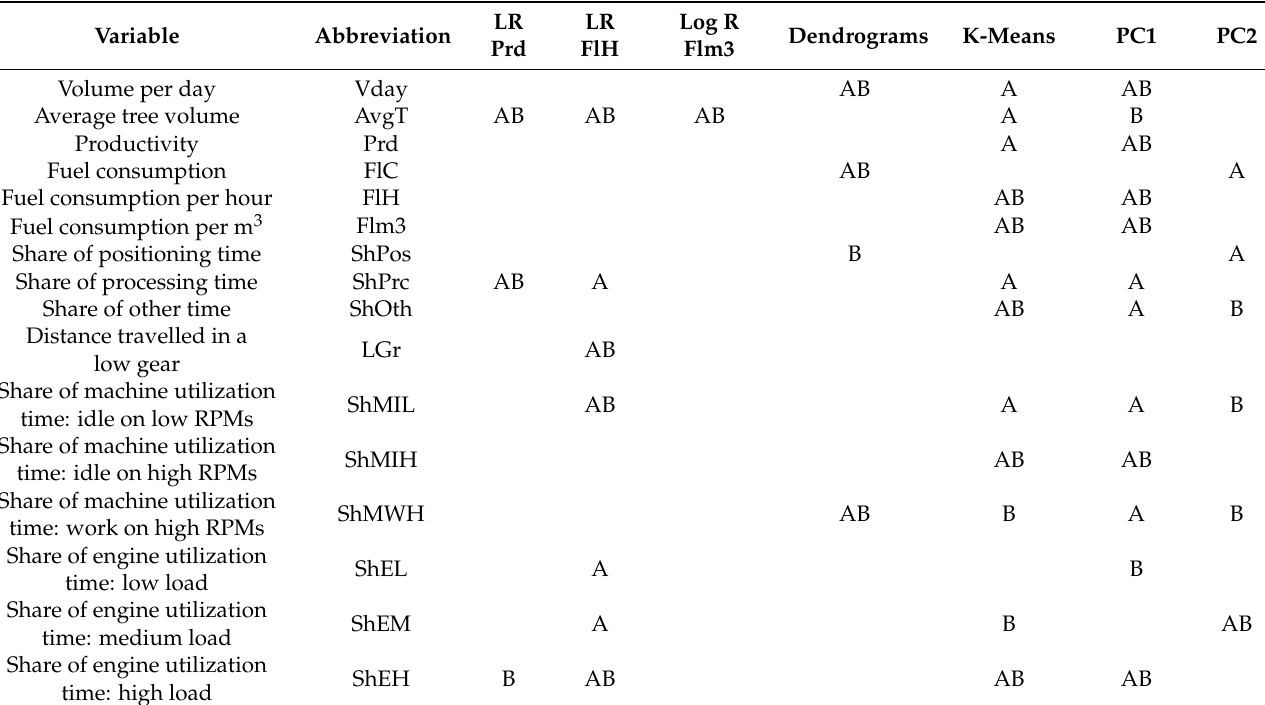
Table 3. Variables with greatest influence in studied methods for both machines (A and